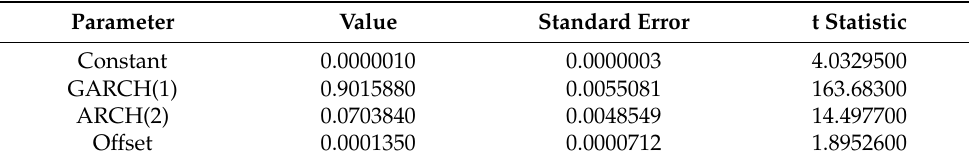
Table 7. GARCH (1,2) model parameters of bjfs residual